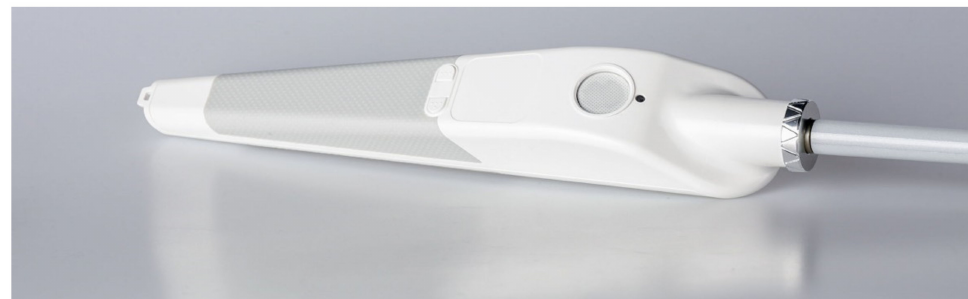
Figure 2. Stock photo of SmartCane™ [38].